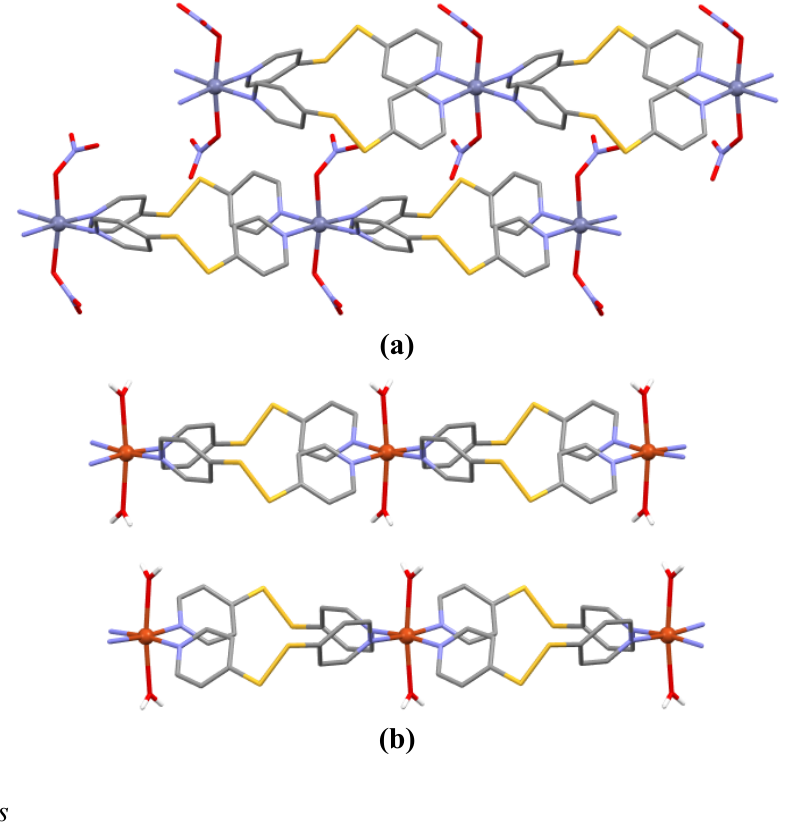
) ( μ - dtdp ) ] (FARLUG) 3 2 2 n }(C H O ) ·4H O] 2 4 3 4 2 2 n